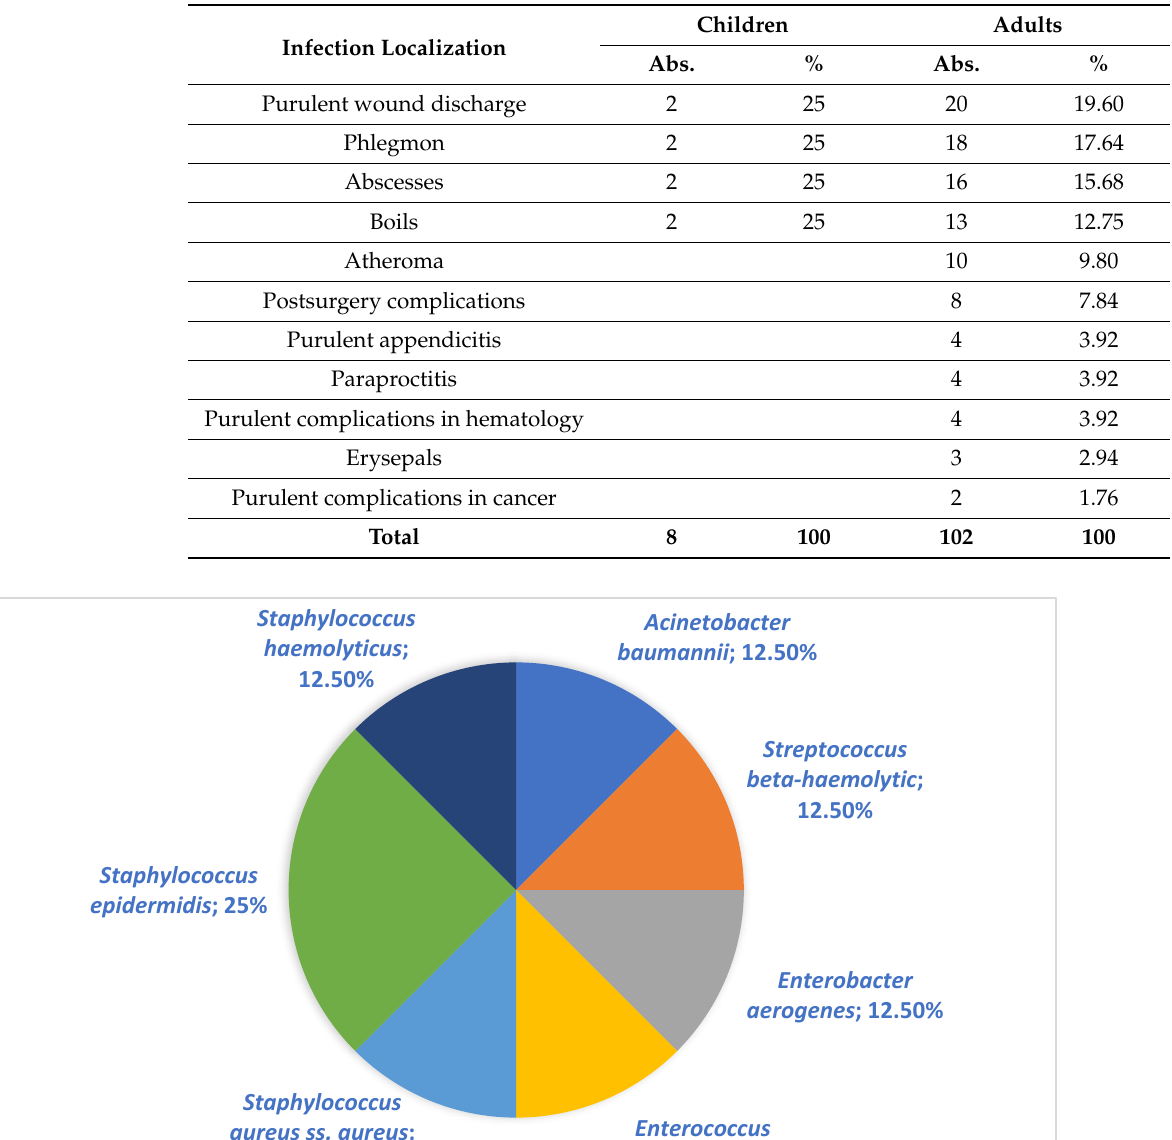
Table 2. Characterization of patients by diagnosis in Karaganda, Kazakhstan, 2018–2020.